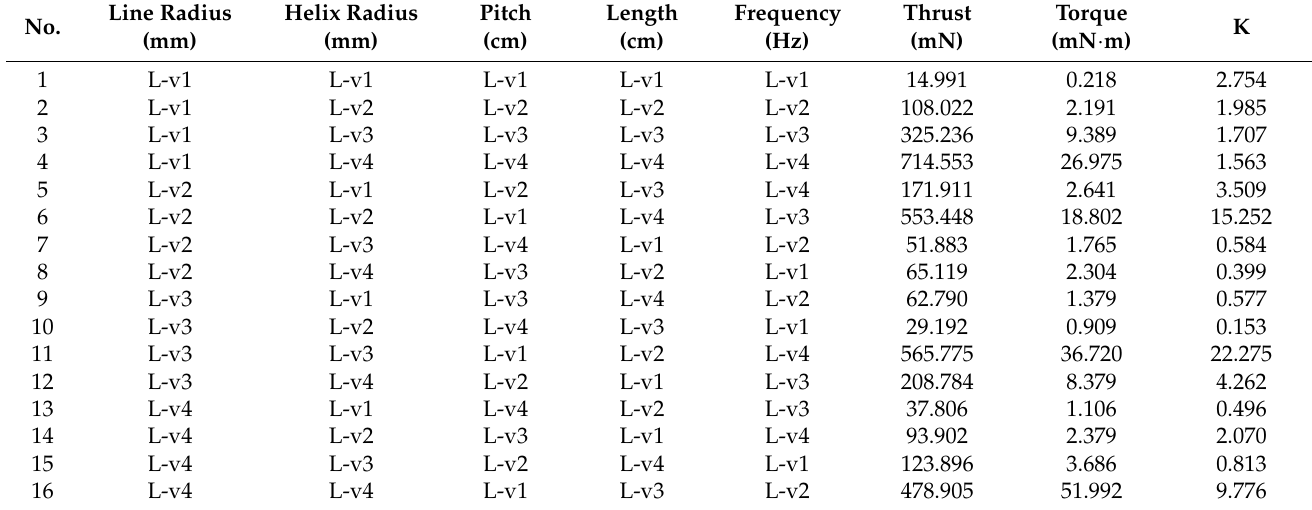
Table 2. Orthogonal analysis table, which contains sixteen typical structures and their three propulsion performance indexes. No.